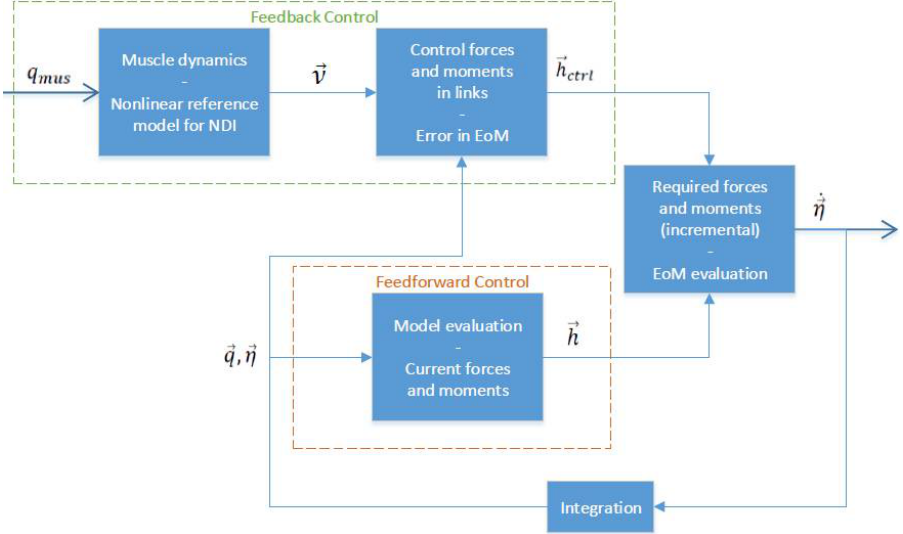
Figure 1. Structure of feedforward-feedback NDI controller for the MBS ski jumper OC model